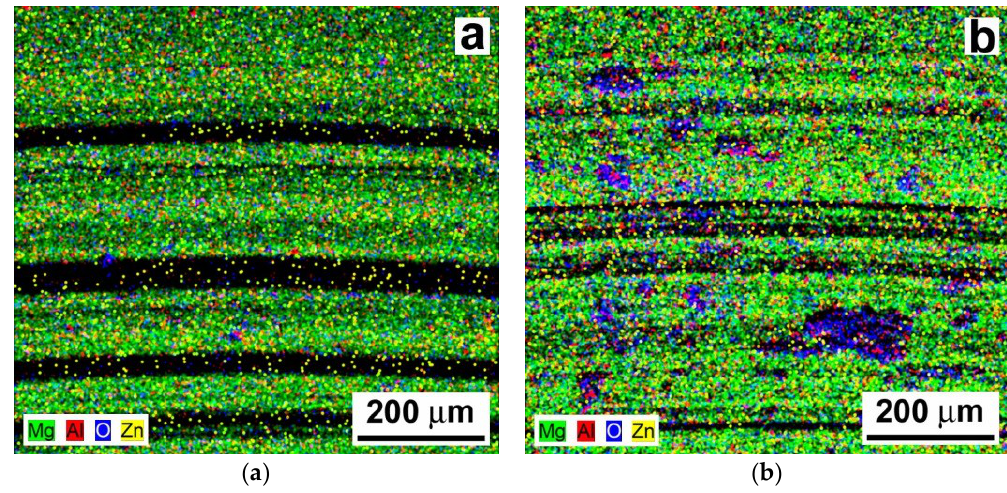
Figure 12. EDX elemental maps from the wear track areas in the AZ61–10 wt.% Al 2 O 3 nanocomposite: ( a ) the laser untreated and ( b ) the laser treated material state.